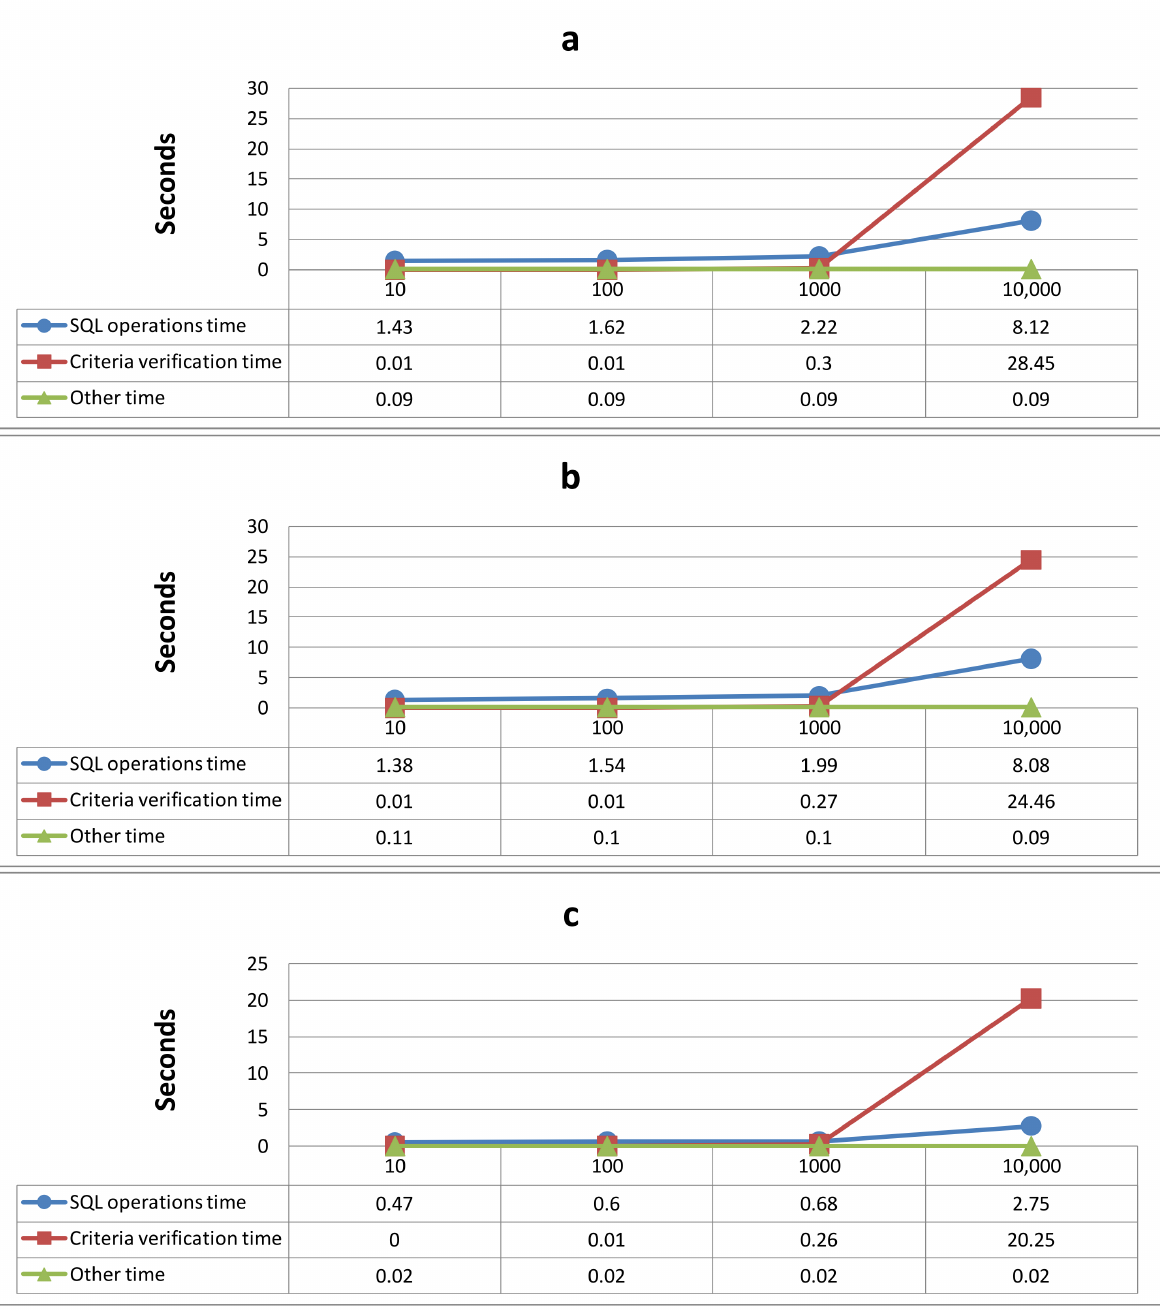
Figure 11. The performances of the system based on the three query tasks in four experiments with different number of patients, including a) degree of liver damage, b) degree of liver damage when applying a mutually exclusive setting, and c) treatments for liver